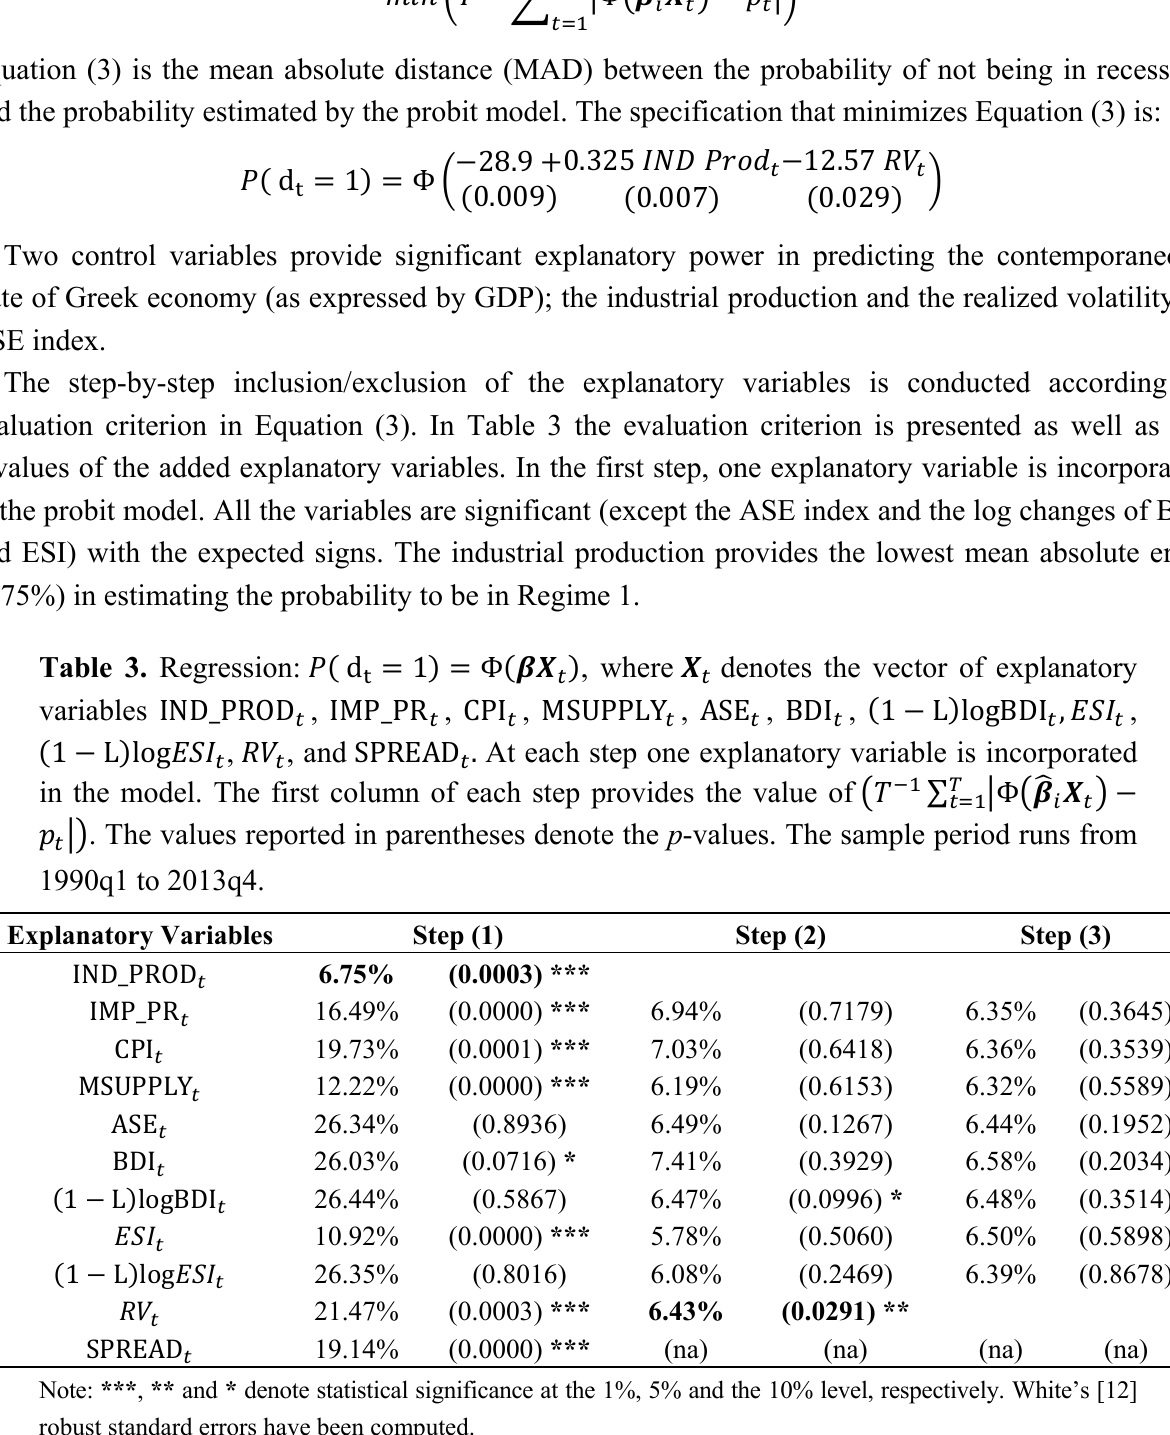
Table 3. Regression: (cid:1842)( d variables IND_PROD